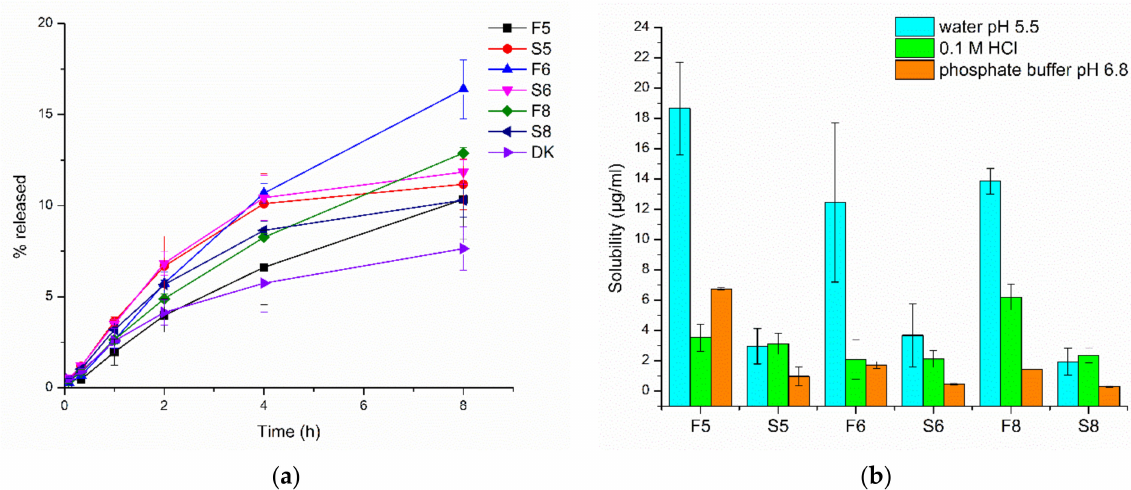
Figure 6. ( a ) Dissolution profiles of nanocrystal dispersions (F5, F6, and F8), corresponding suspensions (S5, S6, and S8) and coarse DK-I-60-3 ( p < 0.05: F5 vs. S5 (20 min), F5 vs. S5 (60 min); F6 vs. S6 (20 min), F6 vs. S6 (60 min), F6 vs. S6 (8 h); F8 vs. S8 (60 min), F8 vs. S8 (2 h), F8 vs. S8 (8 h); F5 vs. F6 (4 h), F5 vs. F6 (8 h); F6 vs. F8 (4 h), F6 vs. F8 (8 h); F5 vs. DK (20 min); F6 vs. DK (20 min), F6 vs. DK (2 h), F6 vs. DK (4 h), F6 vs. DK (8 h); F8 vs. DK (8 h), Univariate ANOVA); ( b ) solubility of DK-I-60-3 in nanocrystal dispersions (F5, F6, and F8) and corresponding suspensions (S5, S6, and S8) in different media at 37 ◦